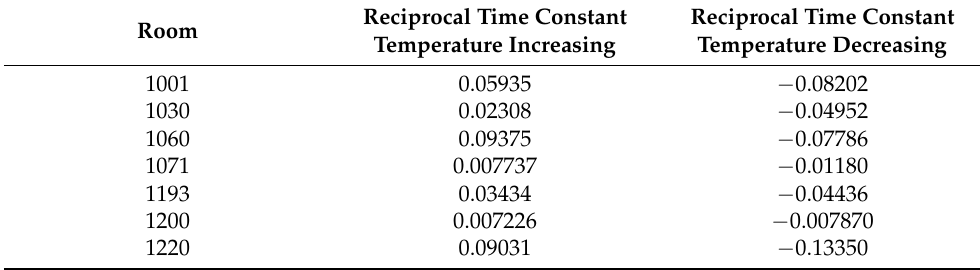
Table 7. Determined reciprocal-time-constants for each room.